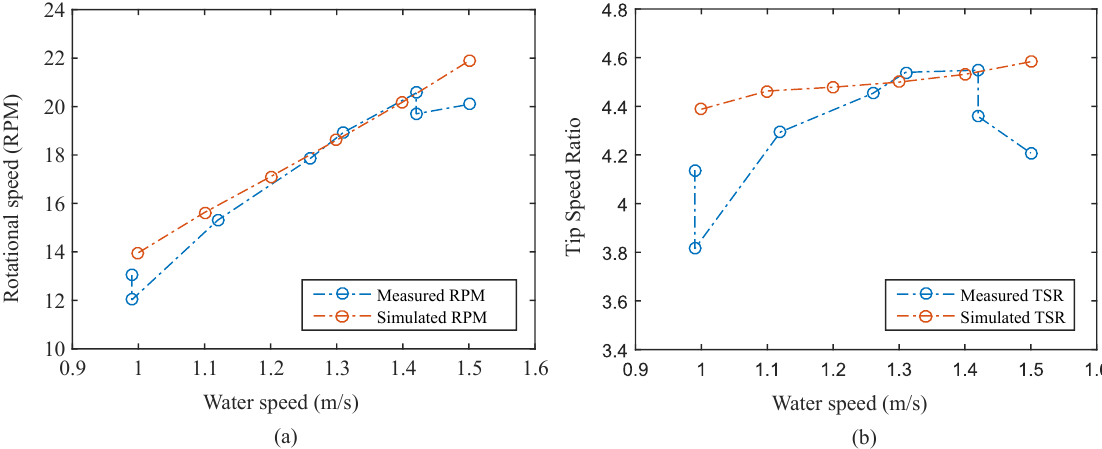
Figure 6. Simulated and experimentally measured free-spin operation of the turbine: ( a ) rotational speed vs water speed; ( b ) Tip-Speed-Ratio vs water